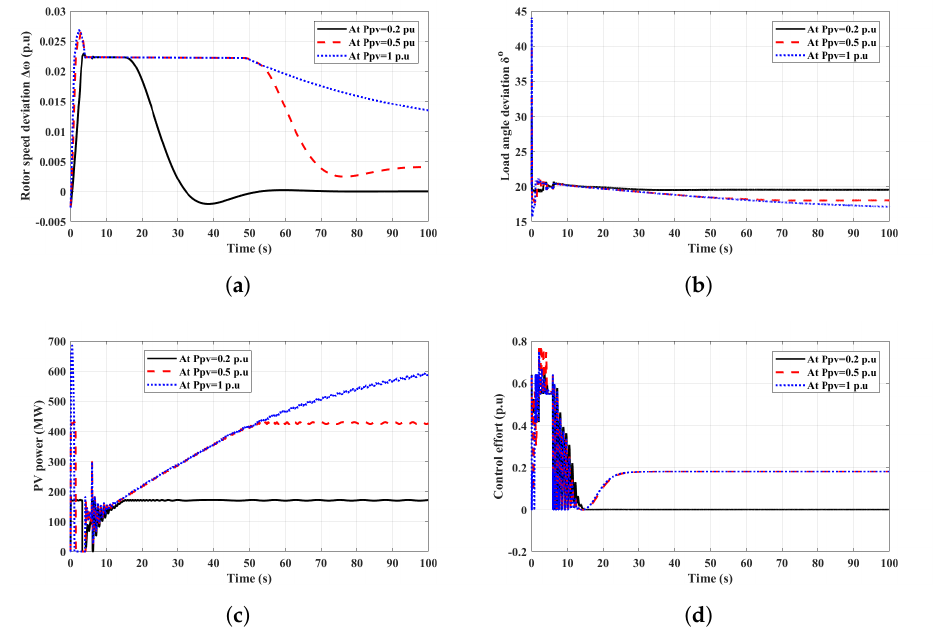
Figure 10. Influence of the PV penetrations. ( a ) Rotor speed deviation. ( b ) Load angle deviation. ( c ) Injected PV power at bus B1. ( d ) control